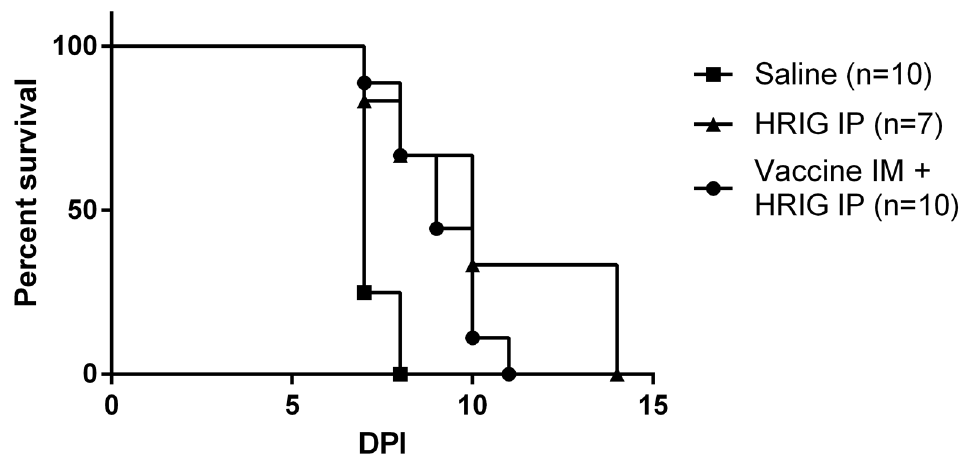
Fig 4. Effect of post-exposure prophylactic treatment with vaccine and human rabies immune globulins on survival in rabies mouse model. Mice were intranasally inoculated with rabies virus followed by treatment with human rabies immune globulins (HRIG) (IP) 24 hours later, either alone or in conjunction with vaccine (IM). Vaccinated mice received a second vaccine dose 3 days later. The control group consisted of mice that were not treated (virus only group). Combined treatment with vaccine and human rabies immune globulins did not differ significantly from treatment with human rabies immune globulins alone and was unable to rescue mice from lethal infection.